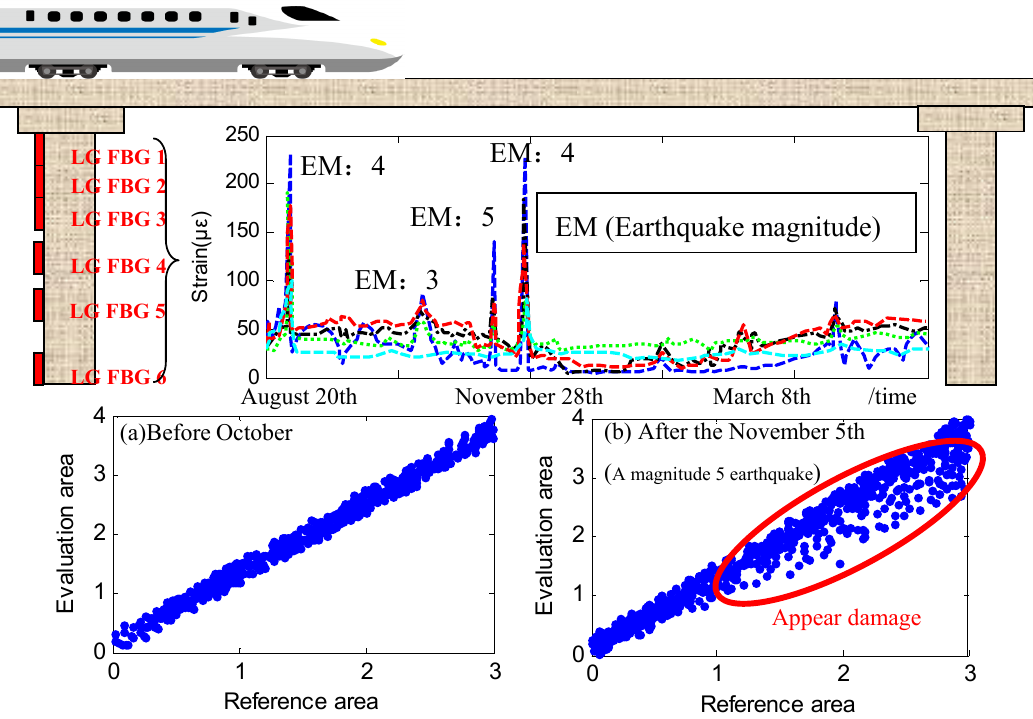
Figure 13. Damage identification of the shinkansen railway bridge by damage fingerprint: ( a ) Before earthquake; ( b ) During earthquake.